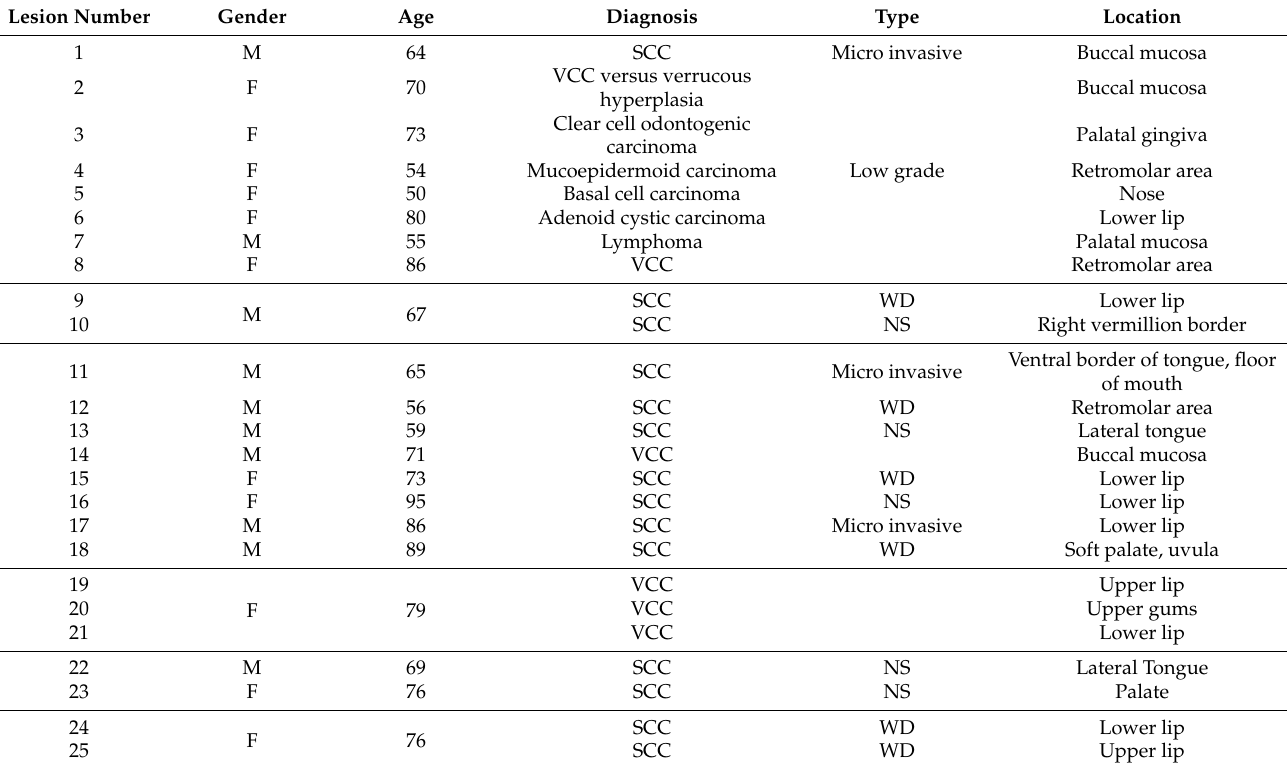
Table 4. Histopathological report of cancerous lesions with patient